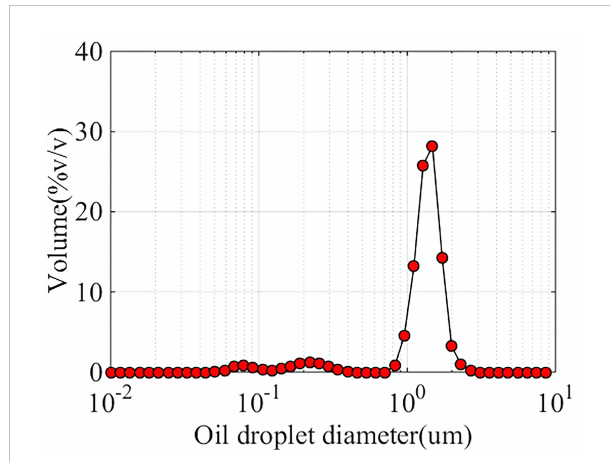
FIGURE 2 Size distribution of oil droplet in oil-based emulsion